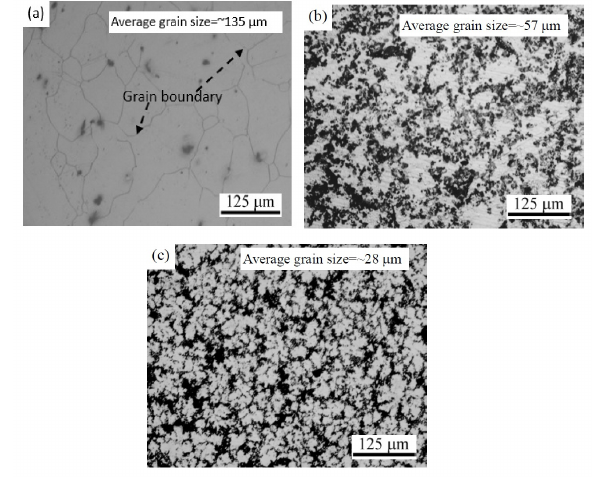
Figure 7: The OM micrographs of the composites. (a) AZ31B alloy, (b)